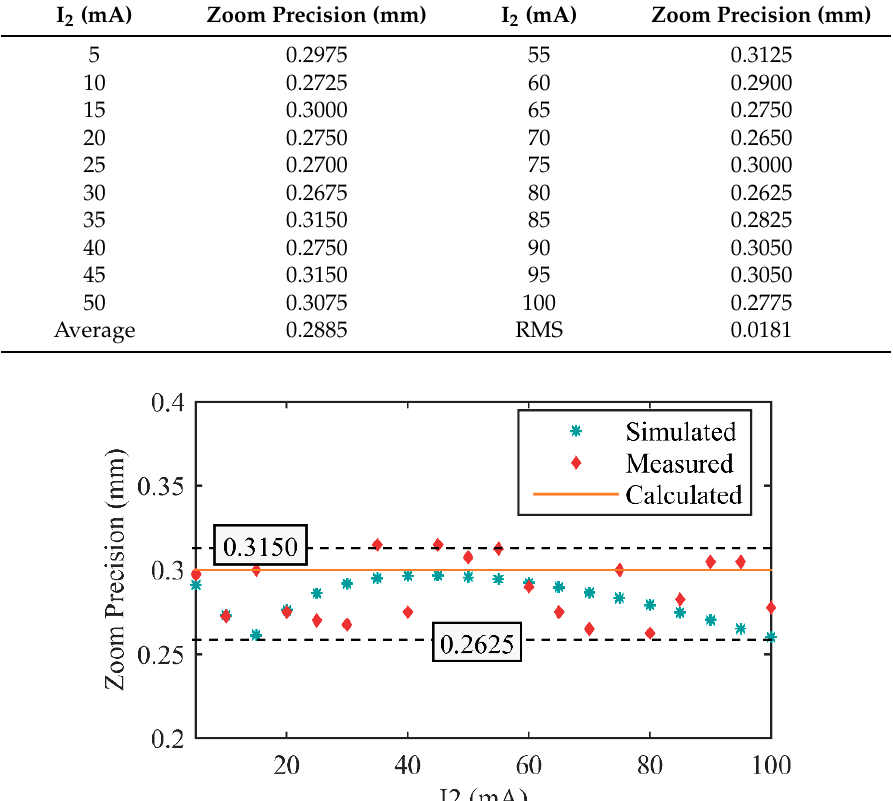
Table 6. Measured zoom precision.